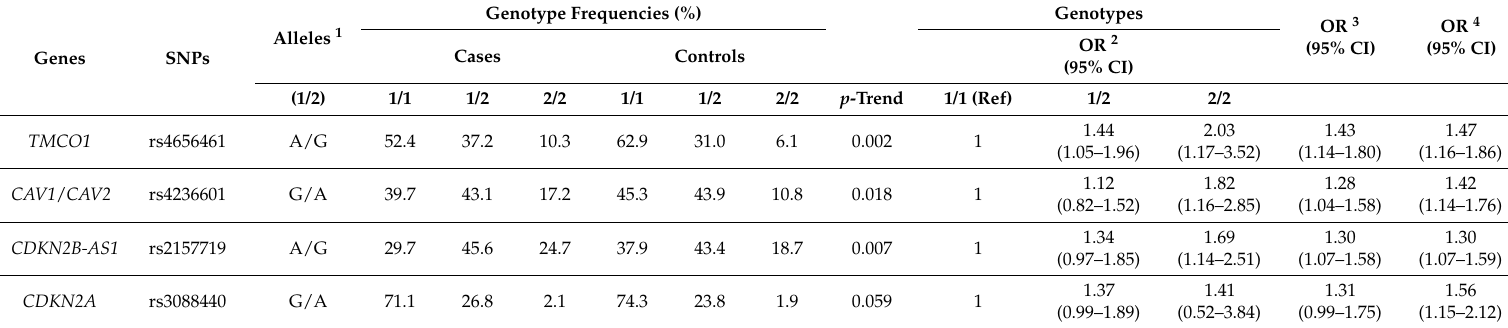
Table 2. Genotypic frequencies of the polymorphisms studied in POAG cases and controls and association with POAG risk.